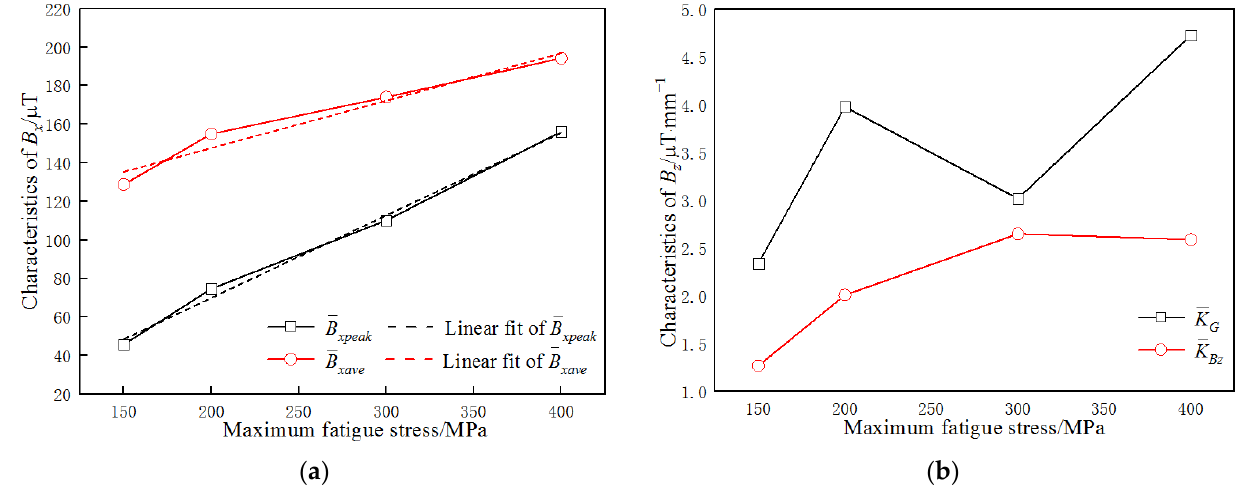
Figure 7. Characteristic variation of MMMT signals with the maximum fatigue stress ( a ) B x signals, ( b ) B z signals. ( b ) B z